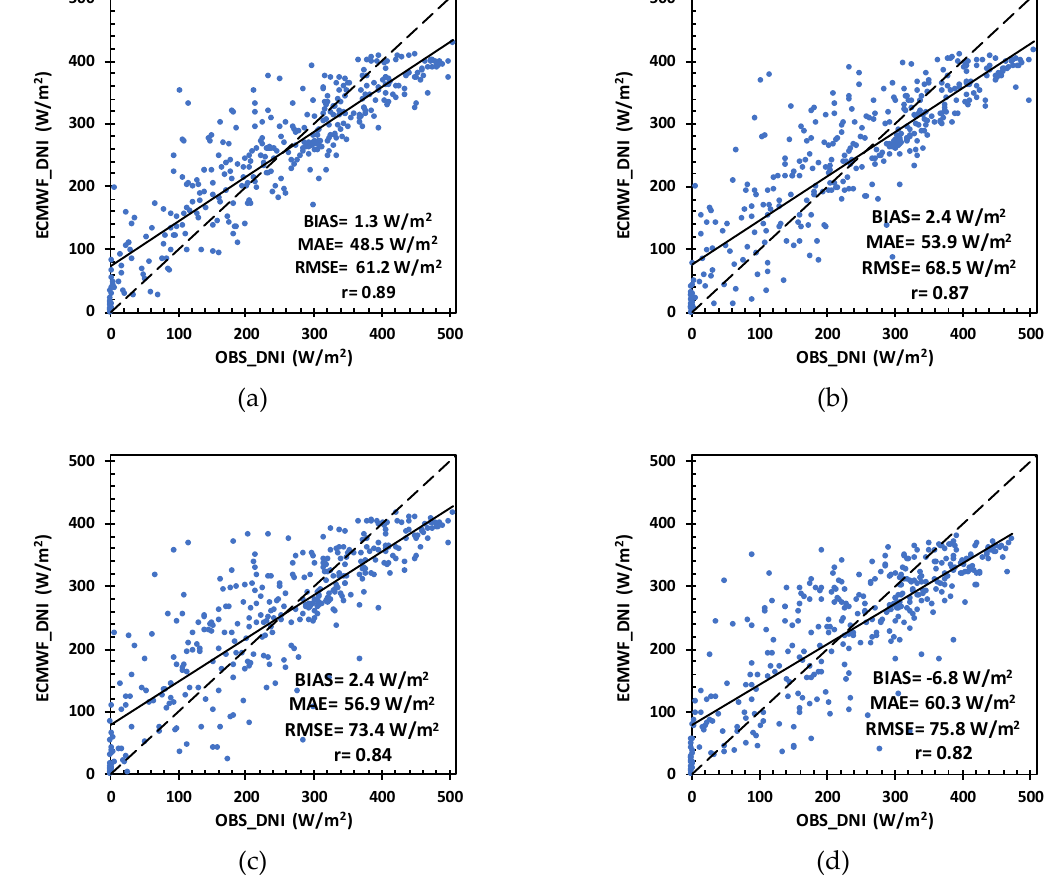
Figure 5. Comparison between predicted and measured daily mean DNI for the four prediction days: ( a ) day_0, ( b ) day_1; ( c ) day_2; ( d ) day_3. MBE, MAE, RMSE, and r are also presented in each plot. The solid lines are the linear fits and the dashed line represents the y = x line.